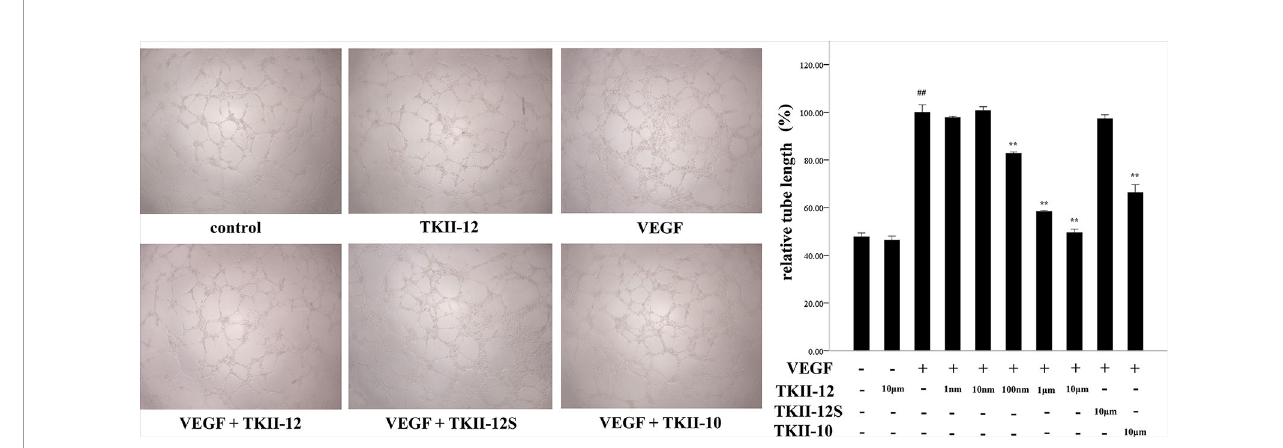
FIGURE 4 | Effects of TKII-12 on vascular endothelial growth factor (VEGF)-induced HRMECs tube formation on Matrigel. The left panel is the representative phase- contrast micrographs of HRMECs exposed to different culture medium at 6 h (magni fi cation 20×). The right panel presents the quantitative graph of the relative percentage of tube length. Each value represents the mean ± SEM of triplicate measurements. ** p < 0.01 versus the VEGF group. ## p < 0.01 versus the control